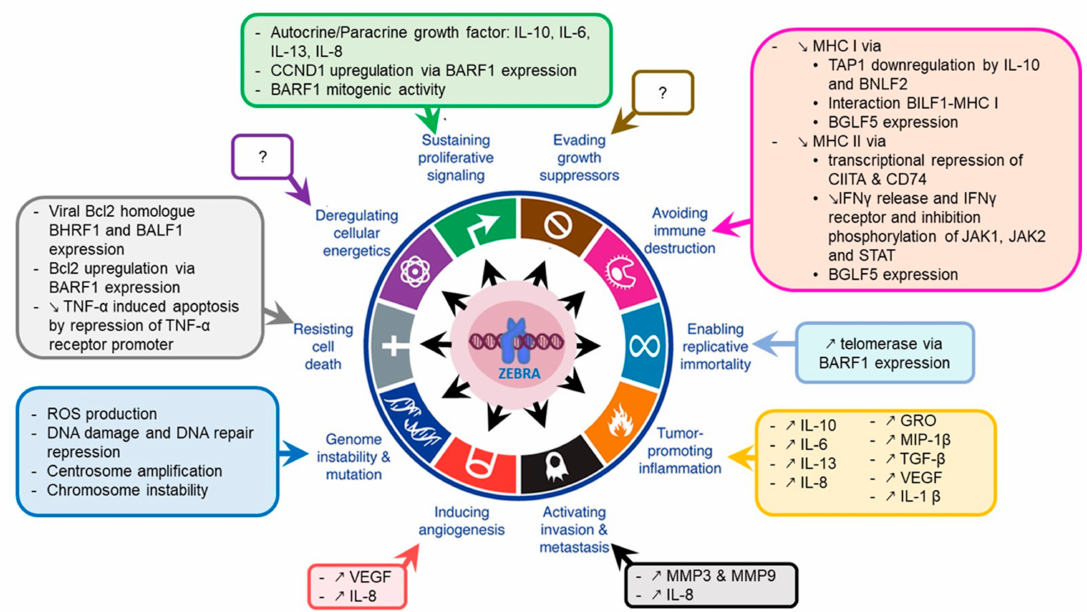
Figure 4. ZEBRA oncogenic properties. ZEBRA directly, or through its target genes, contributes to the acquisition of cancer hallmarks by cells including sustained proliferative signaling, evading or altering the immune response, resisting cell death, enabling replicative immortality, inducing angiogenesis and activating tumor invasion and metastasis. A part of these e ff ects is mediated by genome instability and tumor-promoting inflammation that induce an environment favorable to cancer development and progression. Adapted from